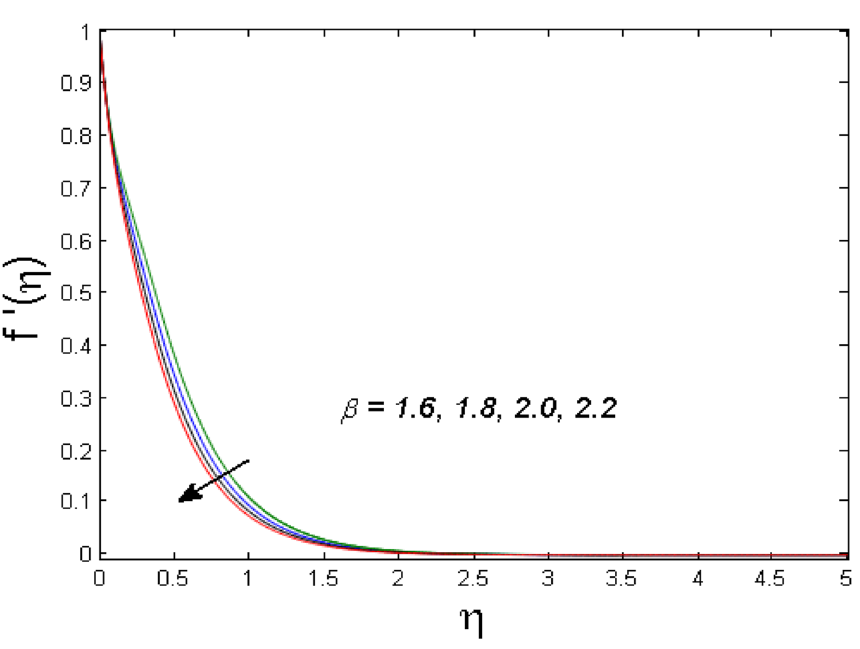
Figure 2. f ′ (η) versus varied estimates of β